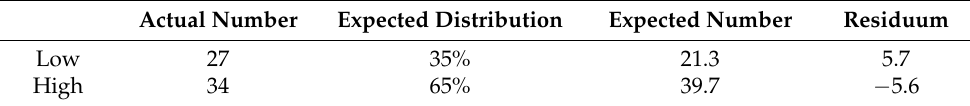
Table 2. Comparison of the MAO-A gene variants distribution in terms of expected versus observed distribution (Low: MAO-A-Gen-Allele 3 R, High: MAO-A-Gen-Allele 4 R, Residuum: Difference between the anticipated number versus the observed number of gene expression variants relative to the sample size).